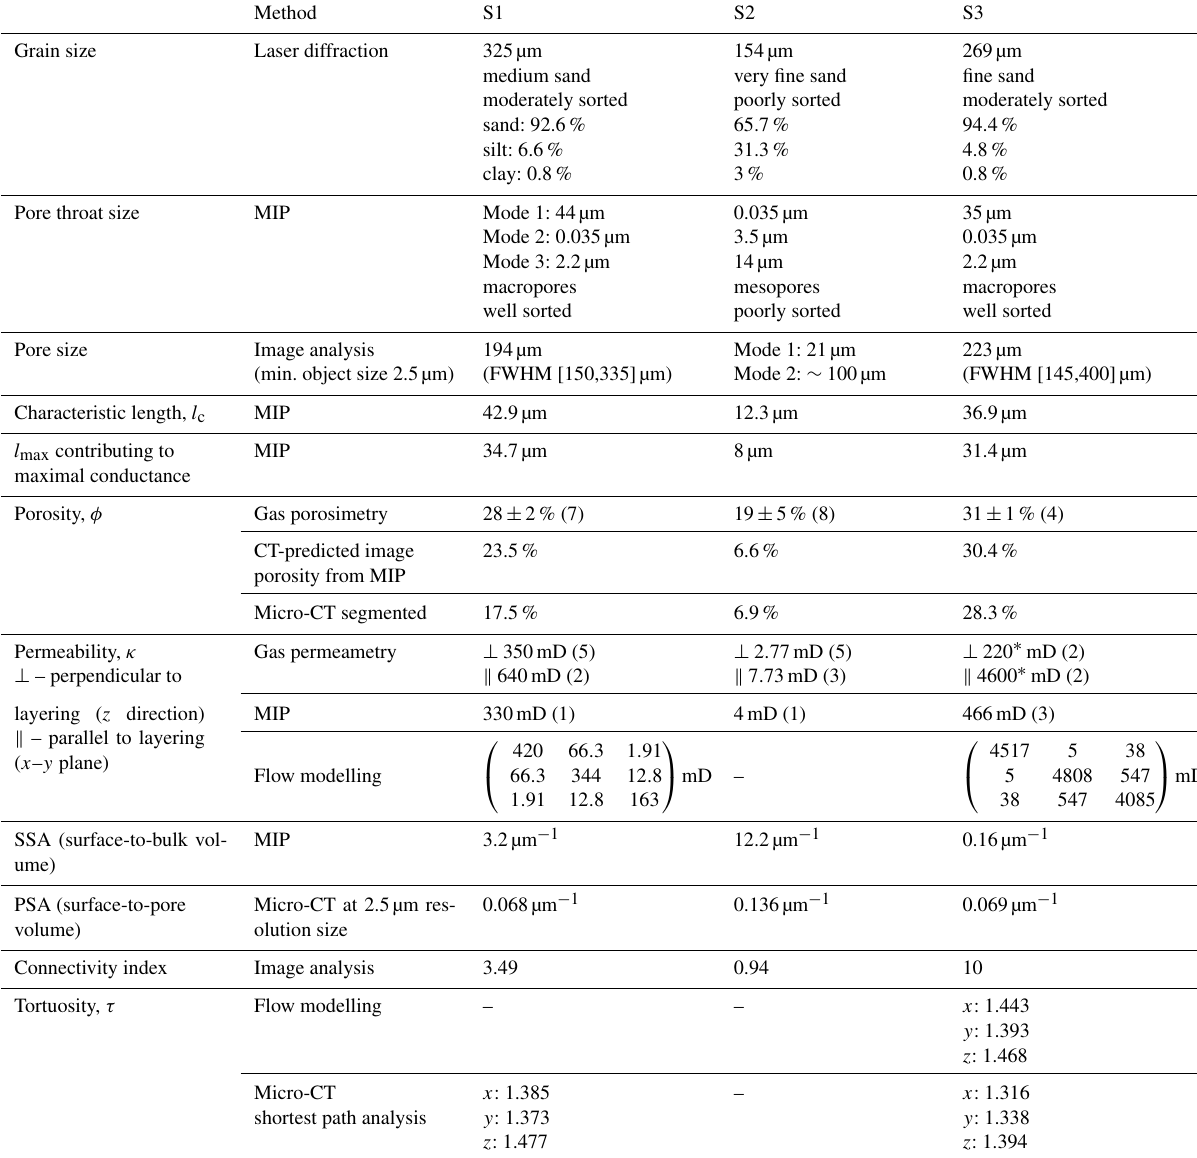
Table 2. Petrophysical characteristics of the three studied sandstone